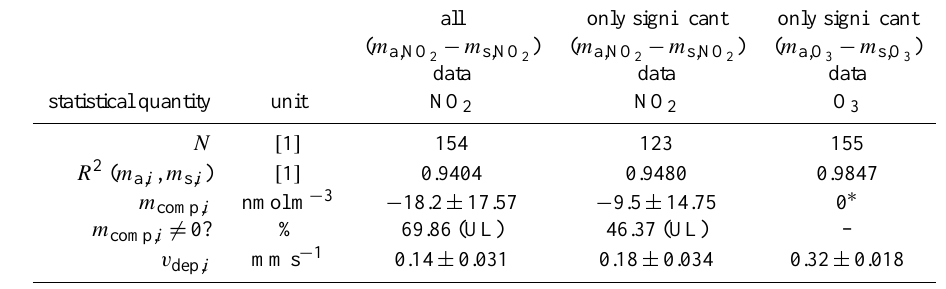
Table 9. Parameters of bi-variate weighted linear least-squares fitting regression analysis for field measurements. NO 2 data were sep- − m arated for all data of 1m NO =( m a,NO s,NO 2 ) and for only significant data of 1m NO 2 . Data of O 3 were always significant for 2 2